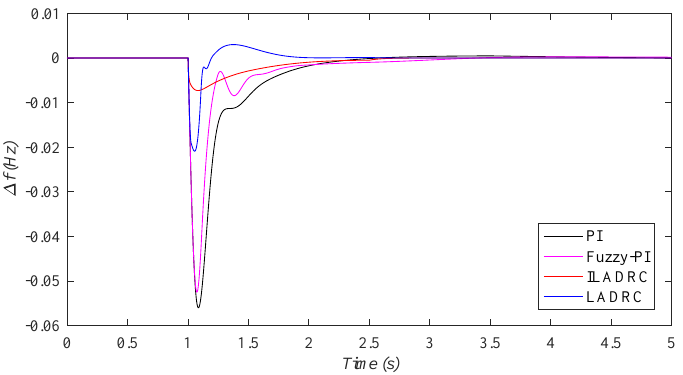
Figure 13. Transient response of system frequency deviation with +0.2 p.u. change of load demand.